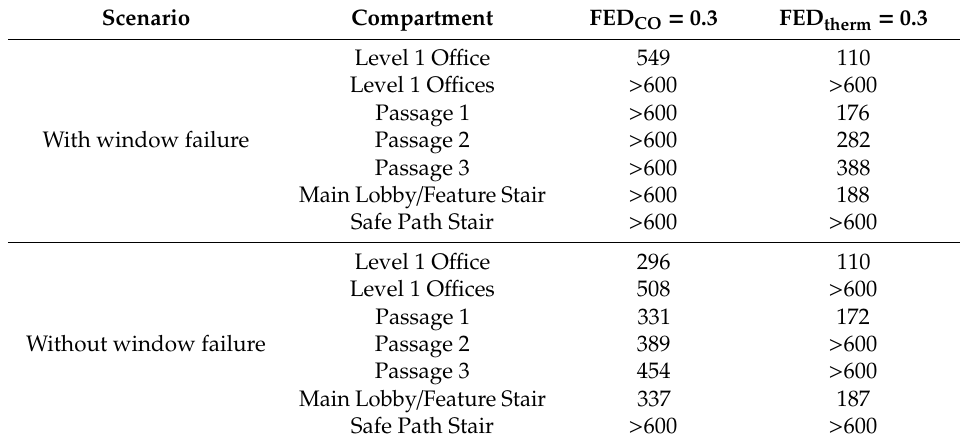
Table 5. Time of FED CO and FED therm reaching 0.3 (in seconds) for modelled spaces of CF5 with and without window